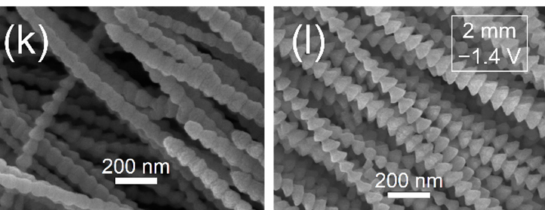
Figure 5. SEM images of Al nanowires on the marginal part ( a , c , e , g , i , k ) and the central part ( b , d , f , h , j , l ) of Cu plate electrodeposited with different thicknesses of insulation ring (inner diameter was 6 mm) at 25 ◦ C: ( a , b ) 0.1 mm, ( c , d ) 0.5 mm, ( e , f ) 1 mm, ( g , h , k , l ) 2 mm and ( i , j ) 3 mm. Deposition potential was ( a – j ) − 1.2 V and ( k , l ) − 1.4 V. Deposition time was ( a – d ) 60 s and ( e – l ) 120 s.